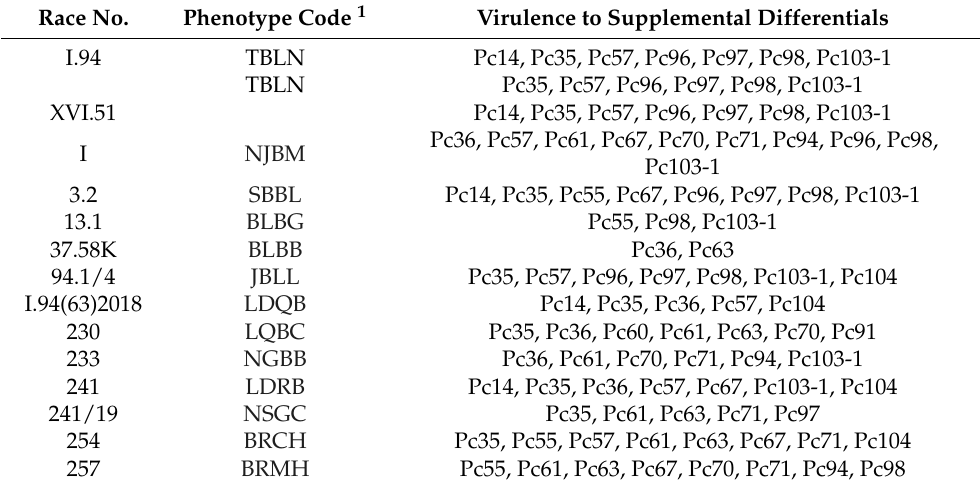
Table 6. Virulence spectrum of P. coronata f. sp. avenae pathotypes used to differentiate Pc50 isolines and target segregation ratio in the Kasztan × Pc50-5, Bingo × Pc50-5 and Pc50 × Pc50-5 progeny. Race